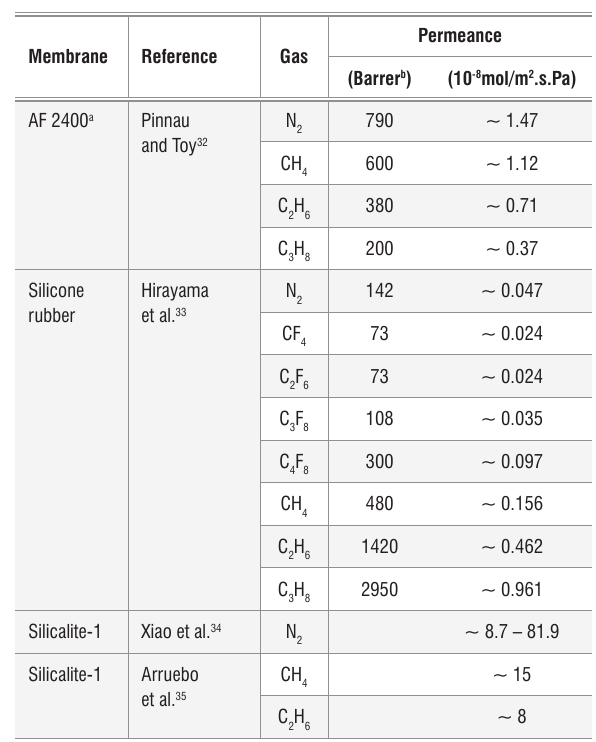
Table 4: Permeability values obtained in previous